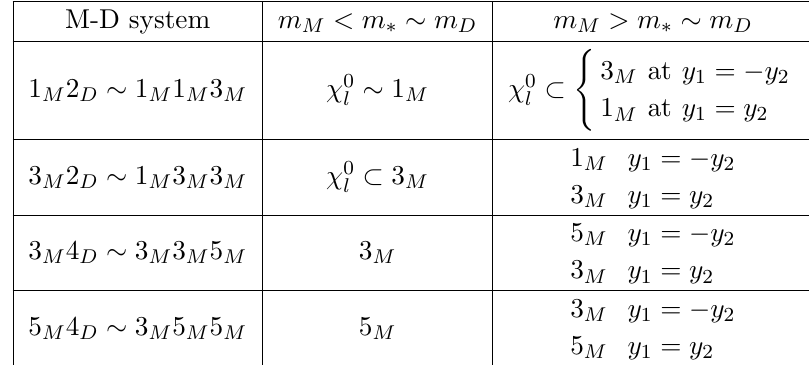
Table 2. After EWSB the Weyl and Majorana states mix. At the custodial points ( y 1 = they combine into multiplets of a custodial SU(2) symmetry. Away from the custodial points, the multiplets component are split, but remain nearly degenerate, thanks to the custodial symmetry. See text. The table shows to which SU(2) multiplet the LNP (lightest neutral particle) (cid:31) 0 for each case. This depends on the mass hierarchy between the bare Majorana and Dirac masses, or more precisely on whether m M is smaller or larger than m (cid:3) = m D